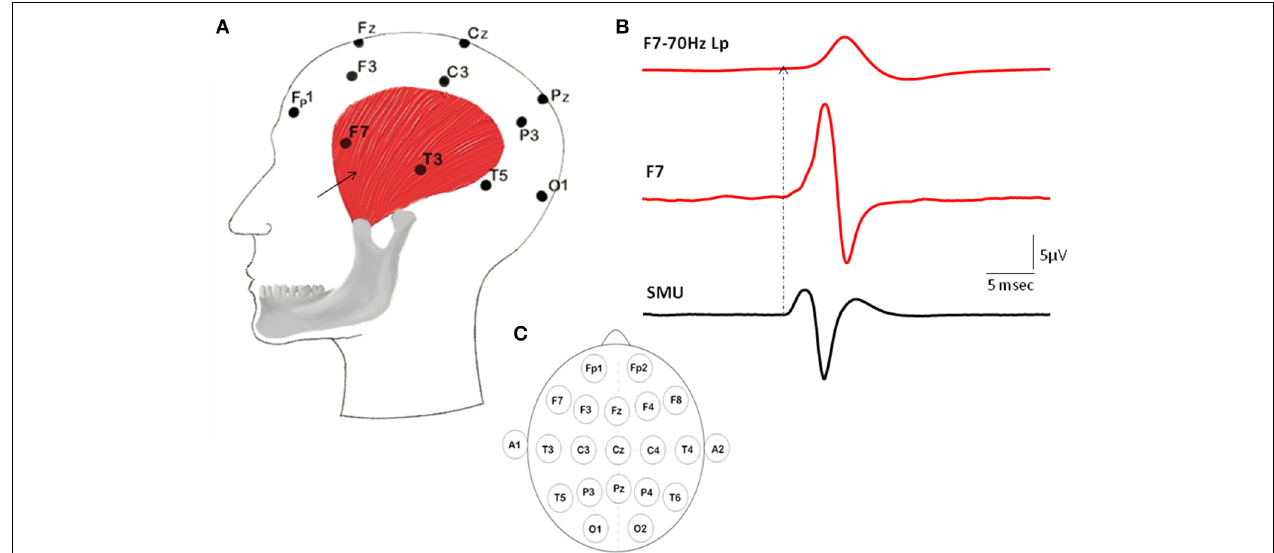
FIGURE 1 | Illustration of the locations of intramuscular electrodes, EEG electrodes, Macro-EMEG, and SMU potential. (A) Intramuscular wire is depicted as a black arrow placed on the anterior temporalis. (B) Represents a Macro-EMEG potential from the F7 electrode with (top)